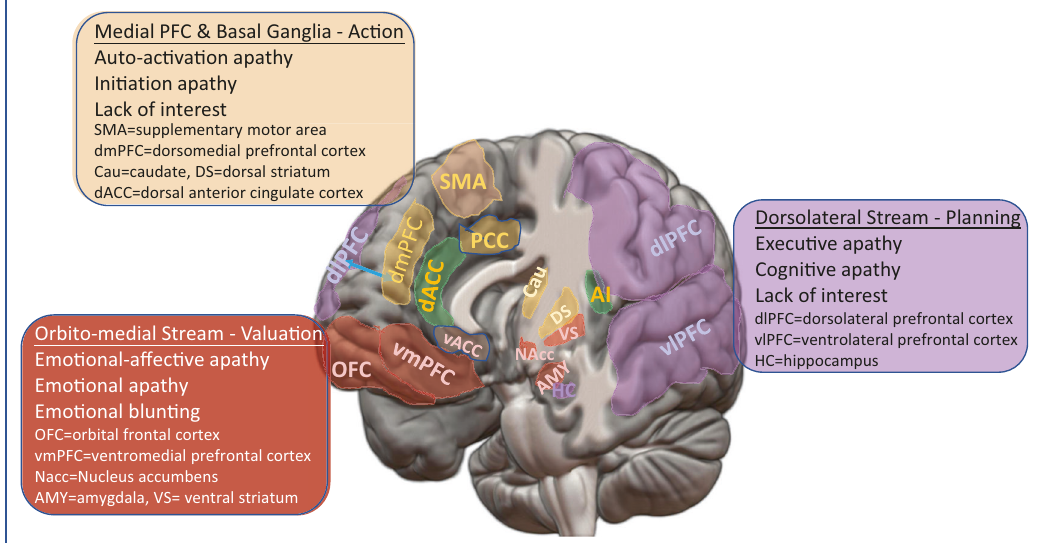
Fig. 1 Multimodality model of apathy (following Levy and Dubois [76]). Brain regions of the same color contribute to the same subtype of apathy. The dorsal anterior cingulate cortex (dACC) and the right anterior insula (AI) comprise the salience network (SN), which monitors switches between internal and external attention and facilitates motivation and decision-making. The dACC connects to the ventral, dorsal, and medial-motor networks, and dysfunction of the dACC can contribute to each subtype of (AI) to measure the three types of apathy and found that “ emotional blunting ” was correlated with hypoperfusion in left superior dlPFC, “ lack of interest ” was correlated with hypoperfusion in right middle OFC, and “ lack of initiative ” was correlated with hypoperfusion in right ACC. The results do not support the hypotheses of Levy and Dubois. Using the three subdomain scores,